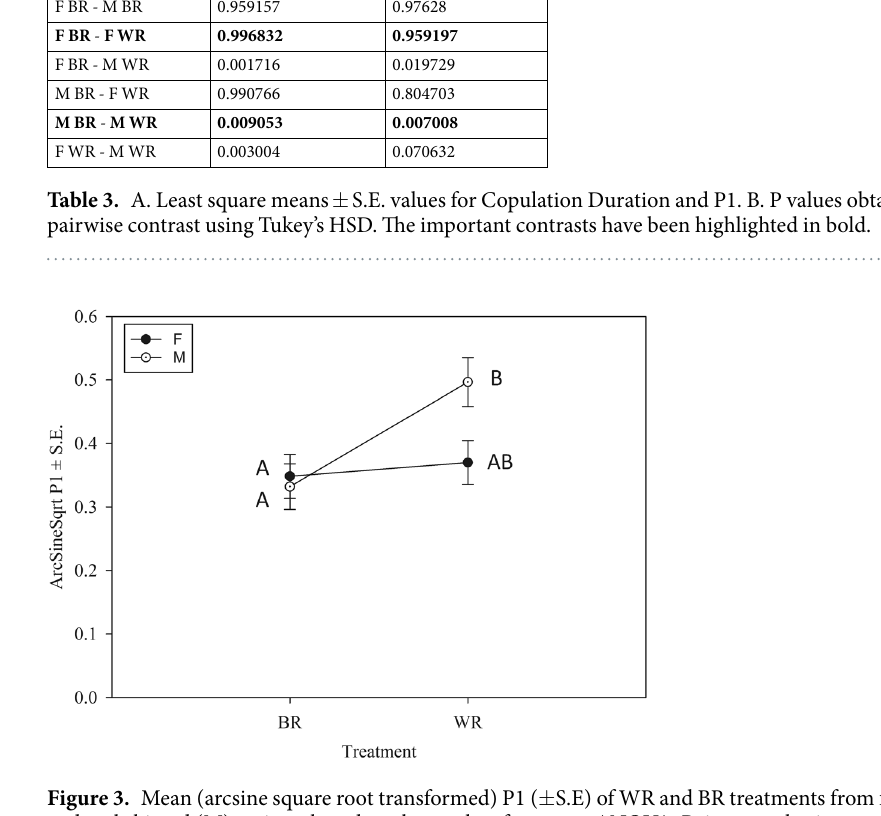
Figure 3. Mean (arcsine square root transformed) P1 ( ± S.E) of WR and BR treatments from female biased (F) and male biased (M) regimes based on the results of two-way ANOVA. Points not sharing a common letter (e.g., A and B) are significantly different based on Tukey’s